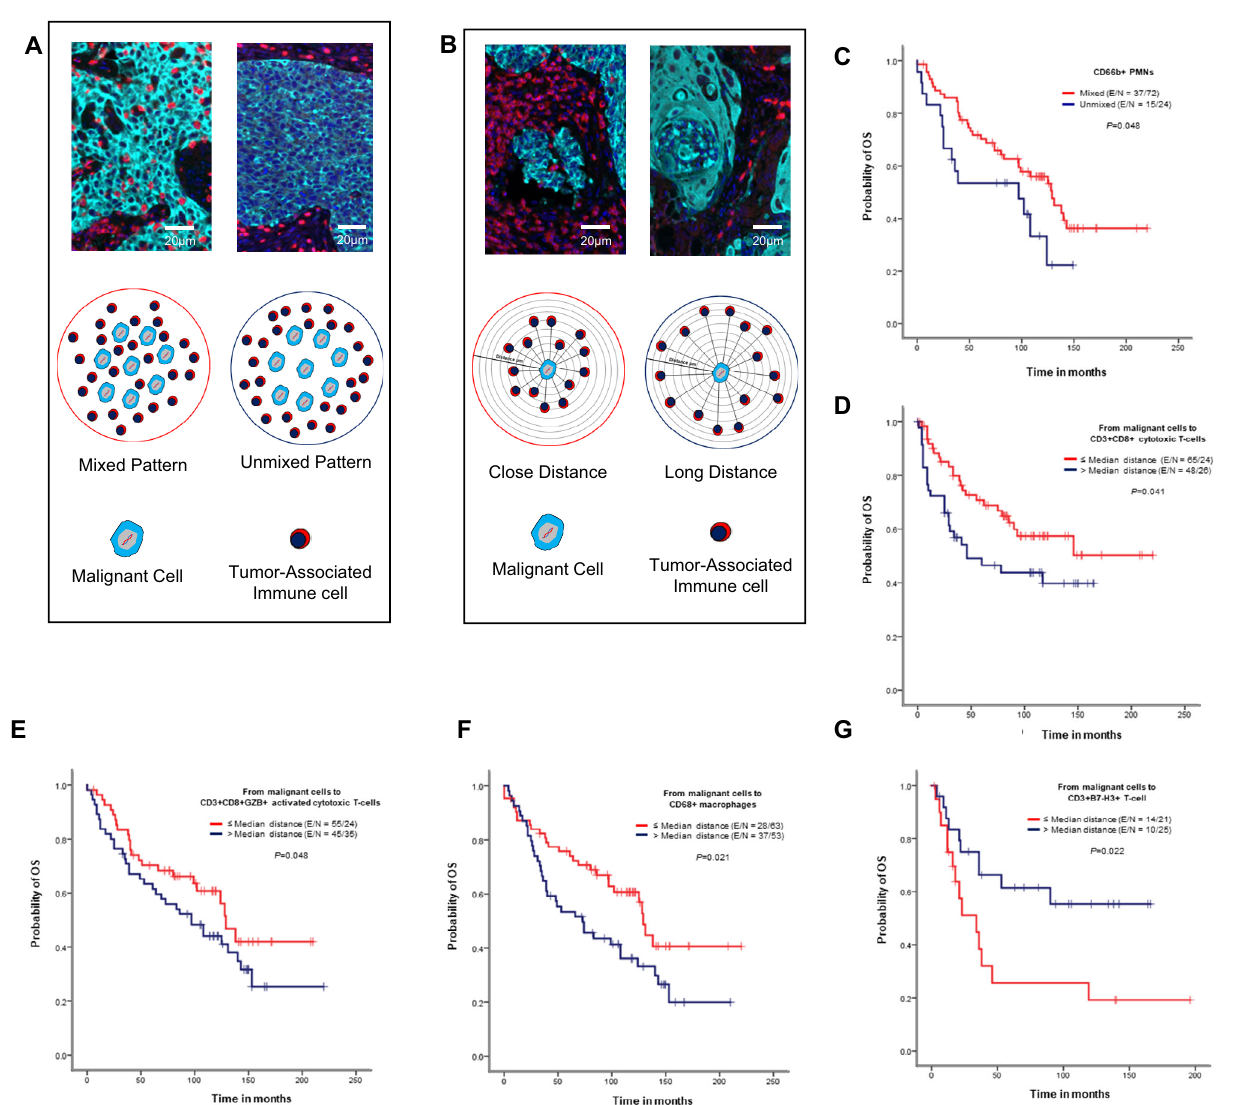
Fig. 6 | Kaplan – Meier analysis of overall survival (OS) by cellular patterns of distribution and distance from malignant cells to various immune cell sub- populations. A Composite spectral mixing images from a detail of multiplex immuno fl uorescence (mIF; 40× magni fi cation scale bars represent 50 µ m on each image) and illustration of the two different patterns of distribution, mixed and unmixed. B Composite spectral mixing images from a detail of multiplex immu- no fl uorescence(mIF;40×magni fi cation,scalebarsrepresent50 µ moneachimage) and illustration of the distance metrics from malignant cells to different immune cells. ( C – G ) Kaplan-Meier OS curves. Red lines indicate mixed pattern or close ( ≤ median)distancesbetweenmalignantcellsandvariouscellphenotypes,andblue lines indicate unmixed pattern or long (>median) distances between malignant cells and various cell phenotypes. C Patients with CD66b+granulocytes (PMNs)